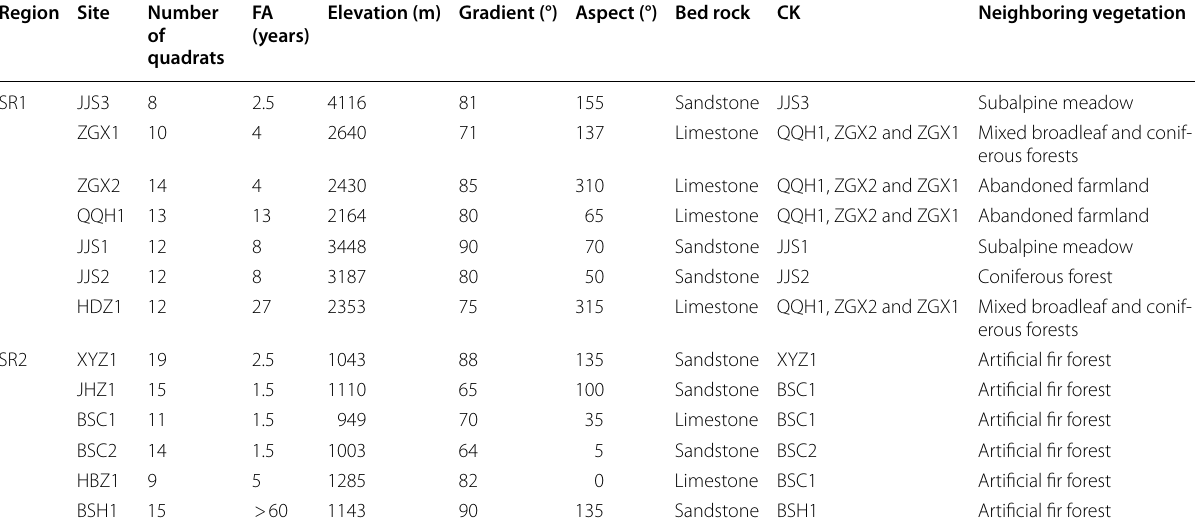
Table 1 Environment characteristics of sampling sites in mountainous regions of west Sichuan, China Region